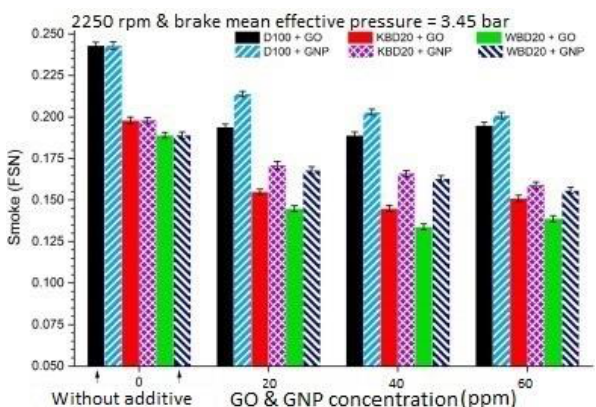
Fig. 10. Variation of smoke emission depending on the concentration GO [5]